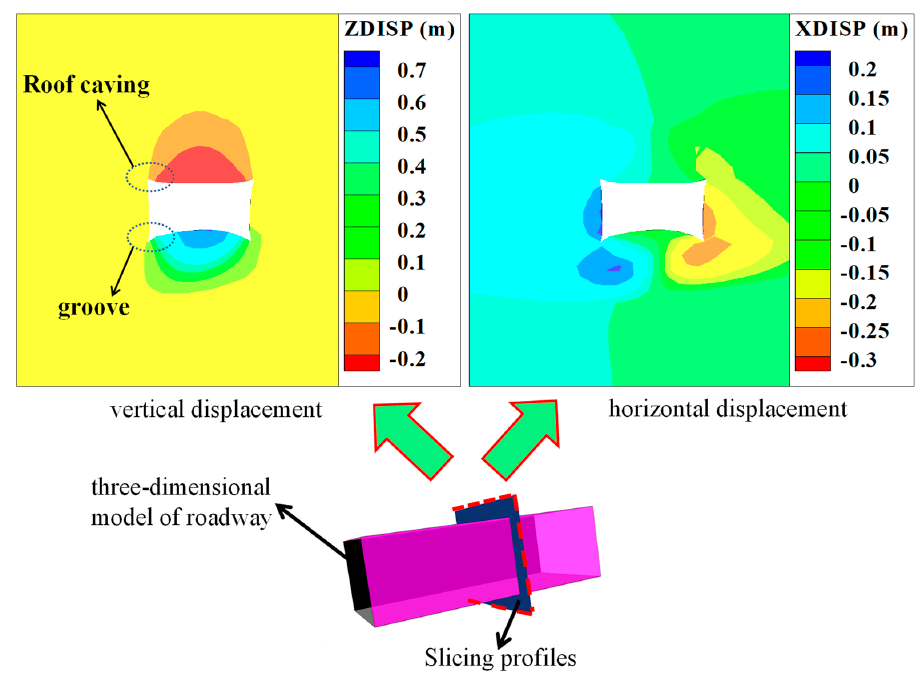
Figure 3. FLAC 3D numerical calculation model.